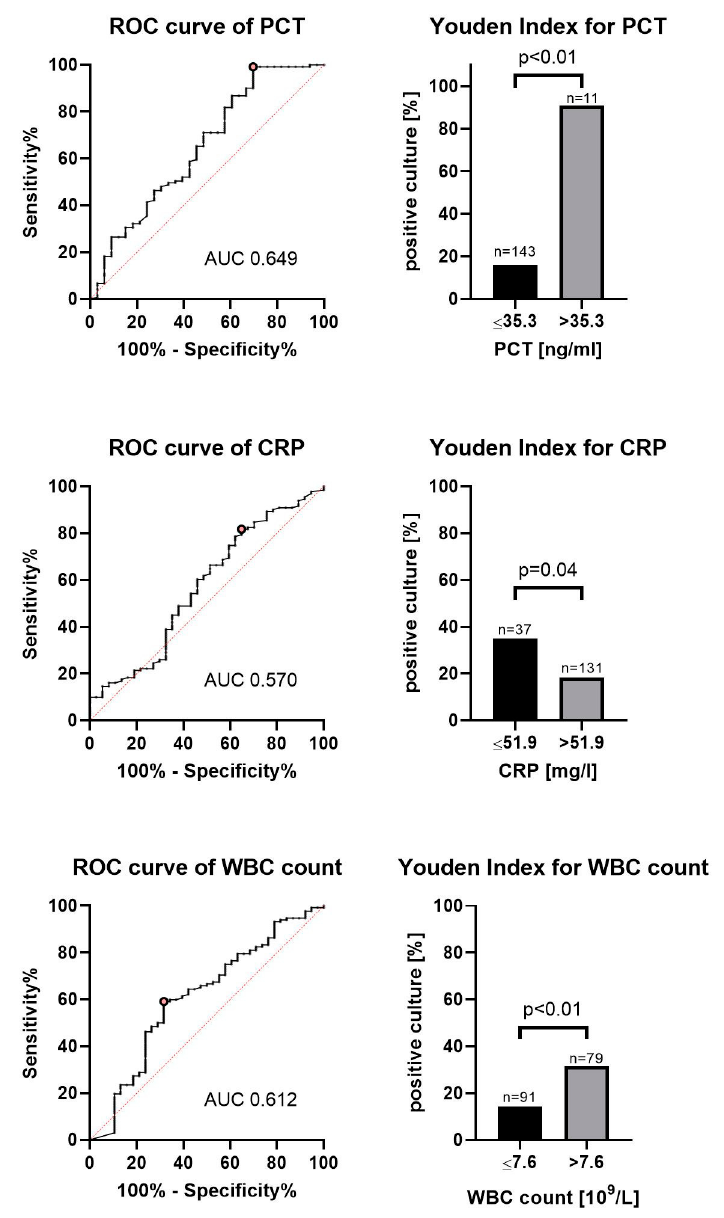
Figure 3. Markers of inflammation in immunocompromised patients. ROC curve showing the diagnostic values of BAL samples positive with relevant bacteria in immunocompromised patients. The best discrimination between the groups according to the Youden Index is given for each marker. Abbreviations: BAL = bronchoalveolar lavage, WBC = while blood cell, CRP = C-reactive protein, PCT = procalcitonin.